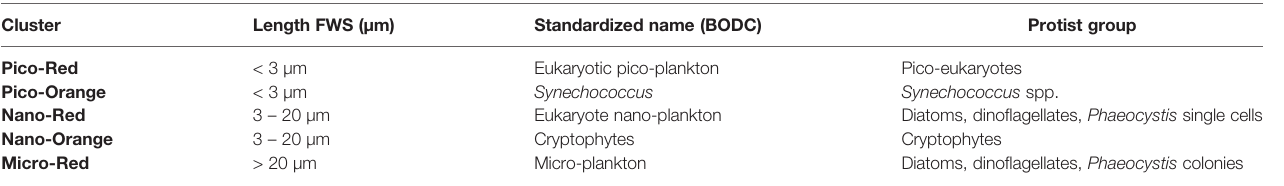
TABLE 1 | Protist clusters detected by FCM, standardized names (https://www.bodc.ac.uk/resources/vocabularies/vocabulary_search/F02/) and main species/groups contributing to these clusters (Roy et al., 2011). Cluster Length FWS